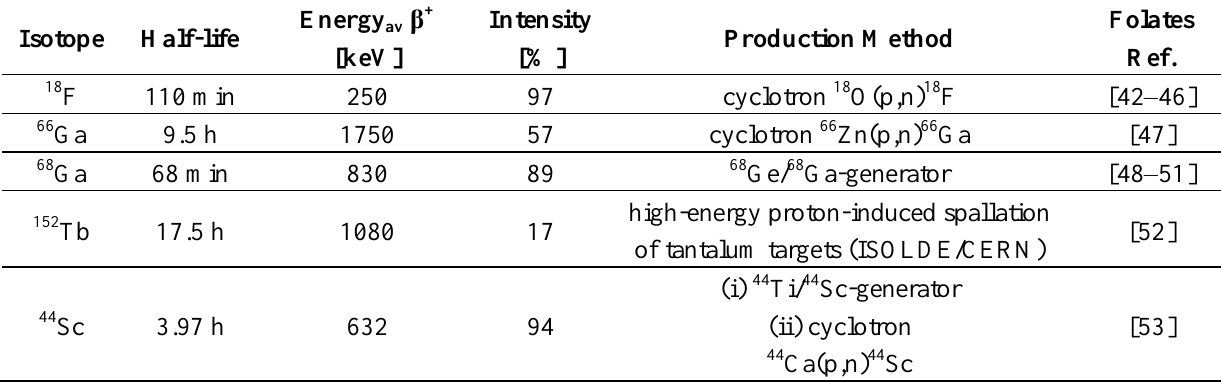
Table 1. PET isotopes employed in conjunction with folate derivatives—physical decay properties and production